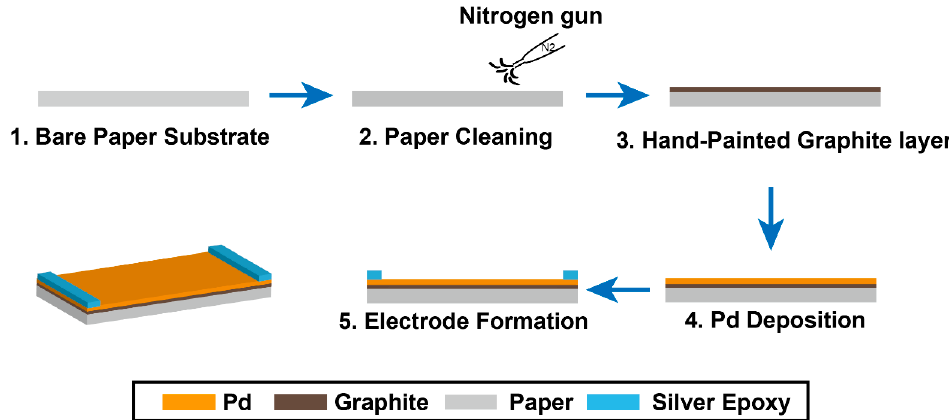
Figure 1. Schematic illustration of the fabrication steps of the palladium (Pd) microfiber network H 2 sensor based on graphite-on-paper (GOP) substrate.